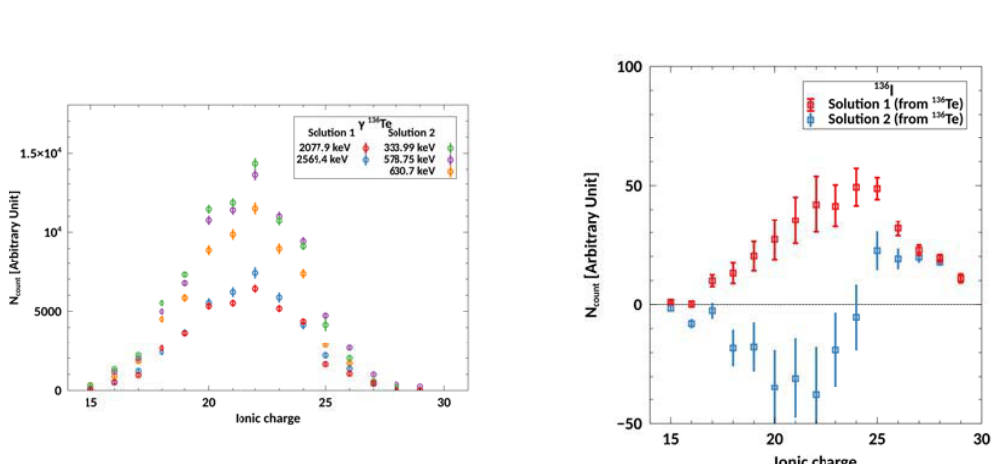
Figure 4. Count rate extracted from γ spectrum (left). Tow di ff erent sets of γ -rays (solution 1 and solution 2) are in agreement within each other. Correction from β − decay of 136 Te to 136 I give rise to two contradictory solutions (right). Data are coming from the studies of the 241 Pu( n th , f )